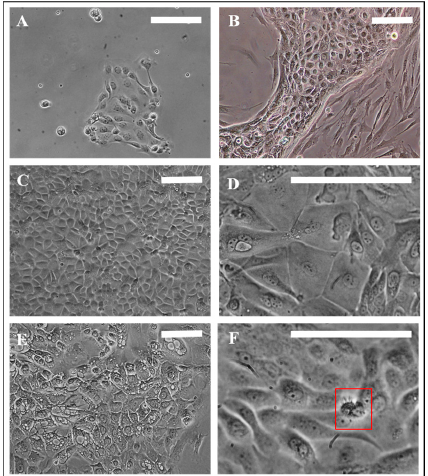
Figure 2. Morphology of porcine primary nasal epithelial cells. ( A ) Olfactory primary cells, 24 h in culture. ( B ) Fibroblast contamination in primary epithelial cells. ( C , D ) Morphological appearance of OEPC and REPC: small round or cobblestone shaped and big flat epithelial cells; cell membranes are clearly visible. ( E ) REPC: vesicular cells. ( F ) Red box: Ciliated cells can be motile or non-motile (beating frequency of >5 Hz). Cilia length was ~10 µm. OEPC: olfactory epithelial primary cells; REPC: respiratory epithelial primary cells; Scale bars: 100 µm.